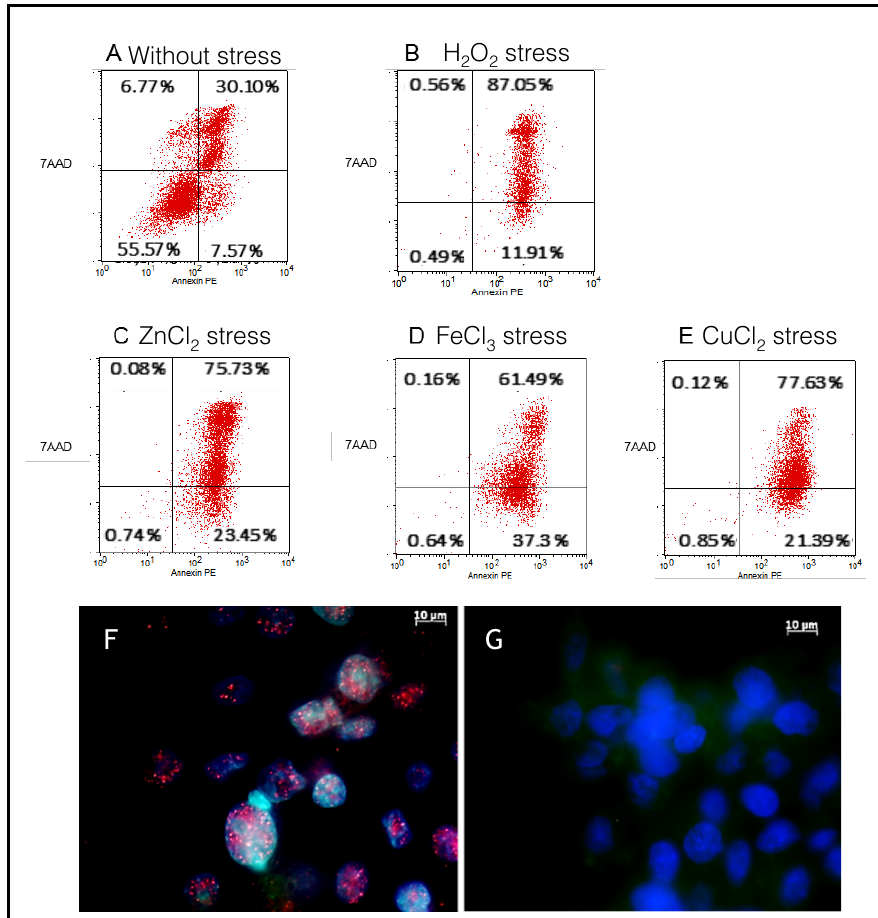
Figure 3. Metal stress-induced SH-SY5Y apoptosis. Annexin V-PE and 7AAD staining assay. Control experiments consisted of negative controls without stress ( A ) and positive controls with H 2 O 2 stress (100 µ M) ( B ). FACS analysis of Annexin V-PE and 7AAD fluorescence signals in SH-SY5Y